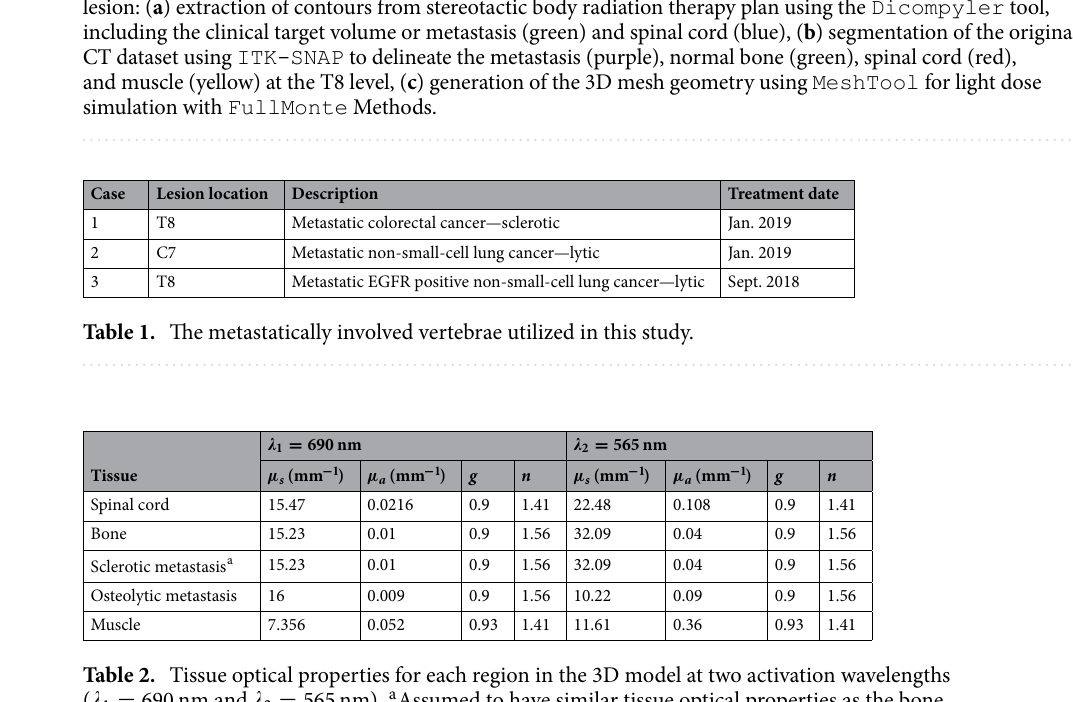
Model specification: optical properties and dose constraints. Table 2 summarizes the tissue optical